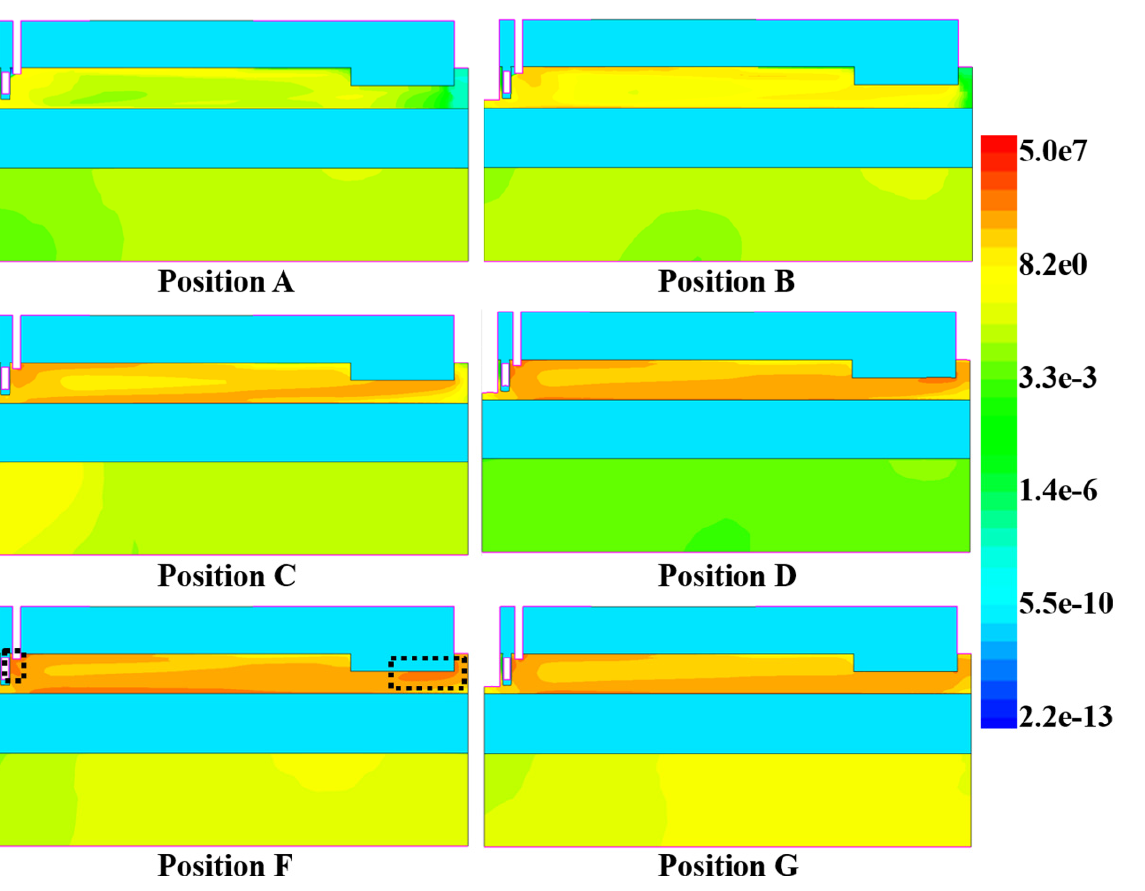
Figure 10. The hole current density distributions of the SJT SOI LDMOS at 0.5 ns after heavy ions with LET of 1 pC/ µ m strike at Position A, Position B, Position C, Position D, Position F, and Position G when V DS is set as 173 V.